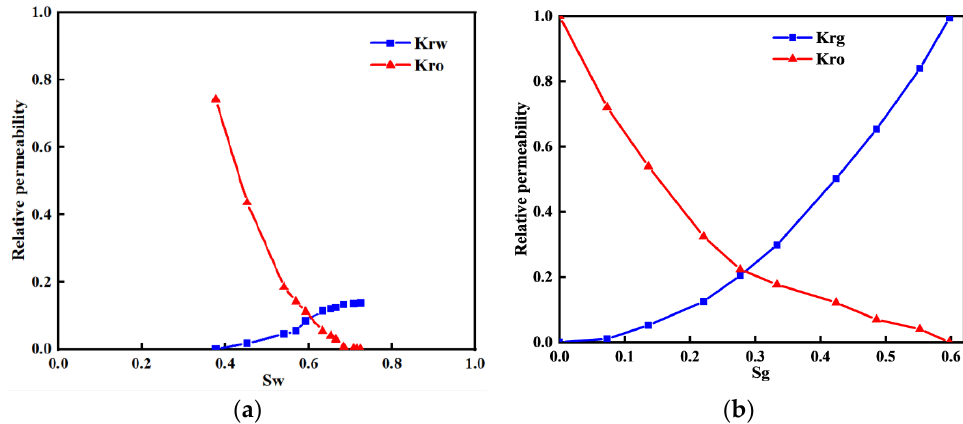
Figure 2. ( a ) Oil – water relative permeability curve; ( b ) oil – gas relative permeability curve.